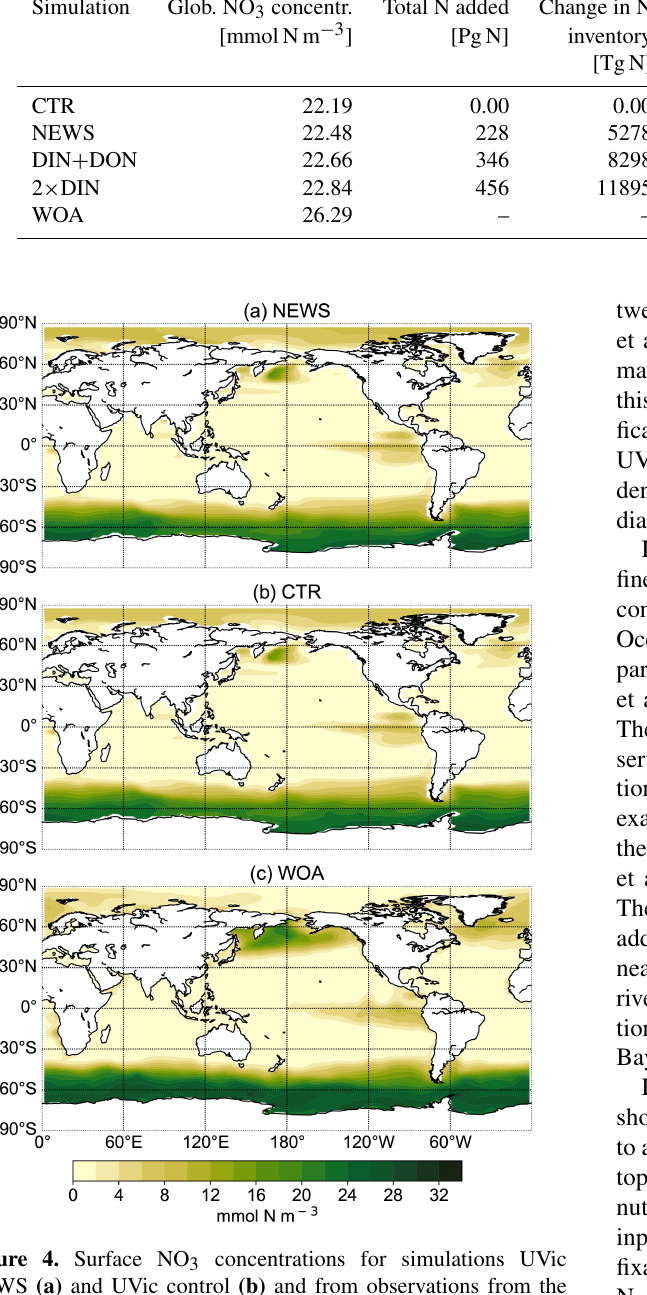
Table 2. Amount of additional nitrogen in teragrams of N at the end of each simulation compared to CTR. Simulation